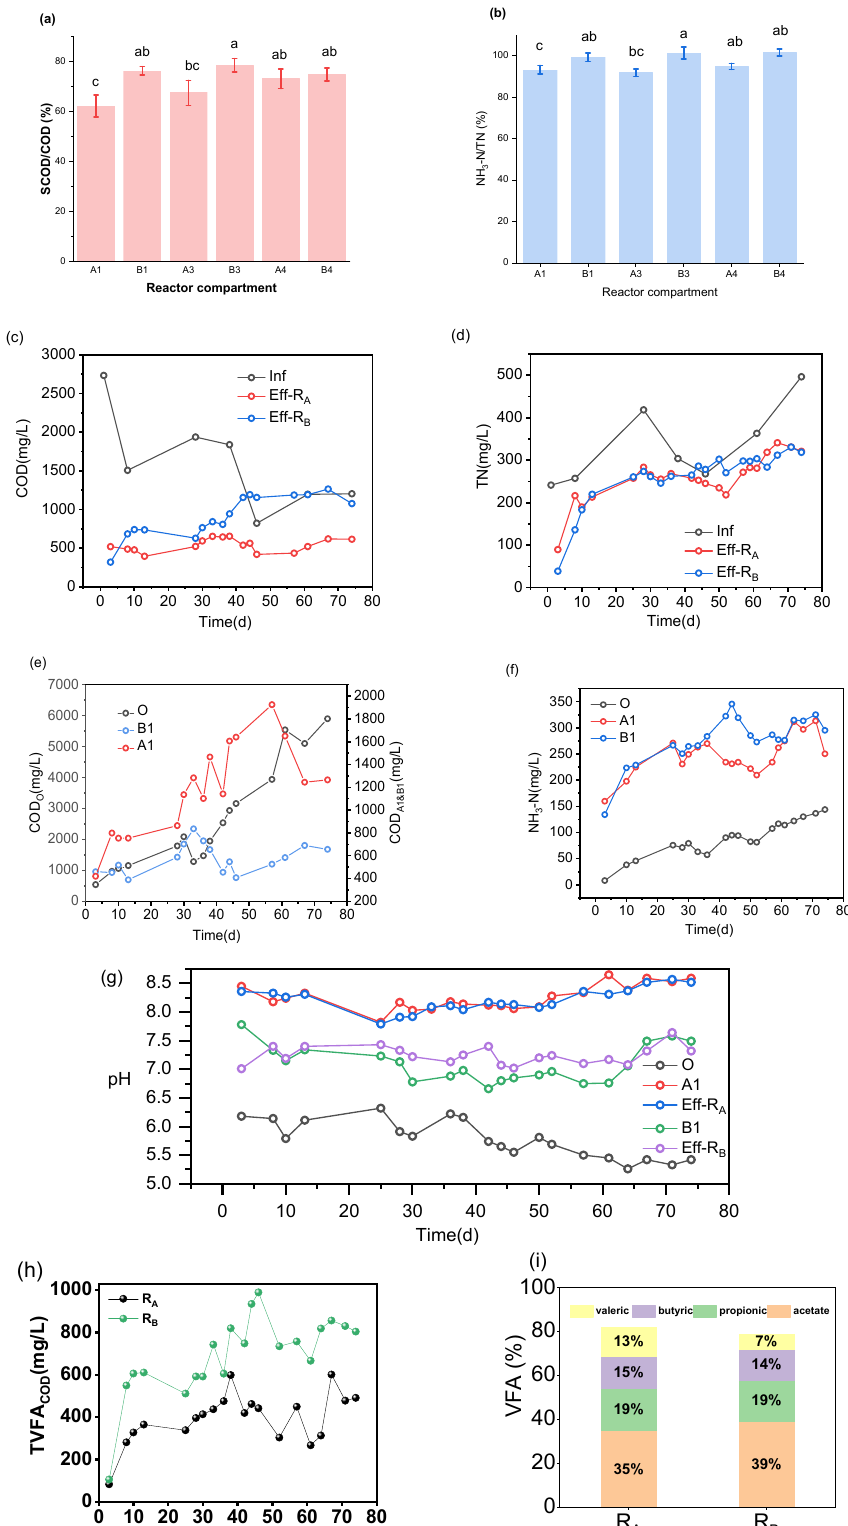
Figure 7. Fermentation effect of two reactors, ( a ) SCOD/COD and ( b ) NH 3 ‐ N/TN, of the last two compartments of R A and R B . ( c ) COD and ( d ) TN concentration in the influent and effluent of two reactors. ( e ) COD and ( f ) NH 3 ‐ N concentration in compartment ‐ O for single digestion FW and the first compartment unit co ‐ fermentation (A1 and B1) of R A and R B . ( g ) pH variation inside the two reactors. ( h ) Variation of TVFA concentration of R A and R B and ( i ) VFA component features in the effluent of two reactors. A1, A3, A4: the first, third, and fourth compartments of reactor A, respec ‐ tively; likewise for B1, B3, and B4 for reactor B. Eff ‐ R B : the effluent of reactor B, likewise for Eff ‐ R A ; Inf: influent; O: the compartment of a single digestion FW unit for reactor A; TVFA COD : COD equiv ‐ alent of total VFAs; R A : Reactor A, two ‐ stage digestion of FW and TW; R B : Reactor B, one ‐ stage digestion of FW and TW. As shown in Figure 6e, the COD variation in the mixing unit (A1, B1) of TW and FW was different. COD concentration in compartment A1 trend was influenced by the increasing COD in compartment O, singly fermenting FW. Indeed, the compartment A1 was able to balance the impact of that action caused by the compartment “O’’ variation. In addition, the effluent from compartment ‘’O’’ was combined with TW influent in the compartment A1, promoting a better hydrolysis balance for the reactor. As shown in Figure 7c,d, under the premise of the same feedstock, the COD concentration in the effluent of R B was ≈ 2 times higher than that of R A . However, there was a gradually increasing NH 3 ‐ N concentration. Figures 7b,d,f and S2 also provide additional supportive results. The ratio NH 3 ‐ N to TN (NH 3 ‐ N/TN) for R B